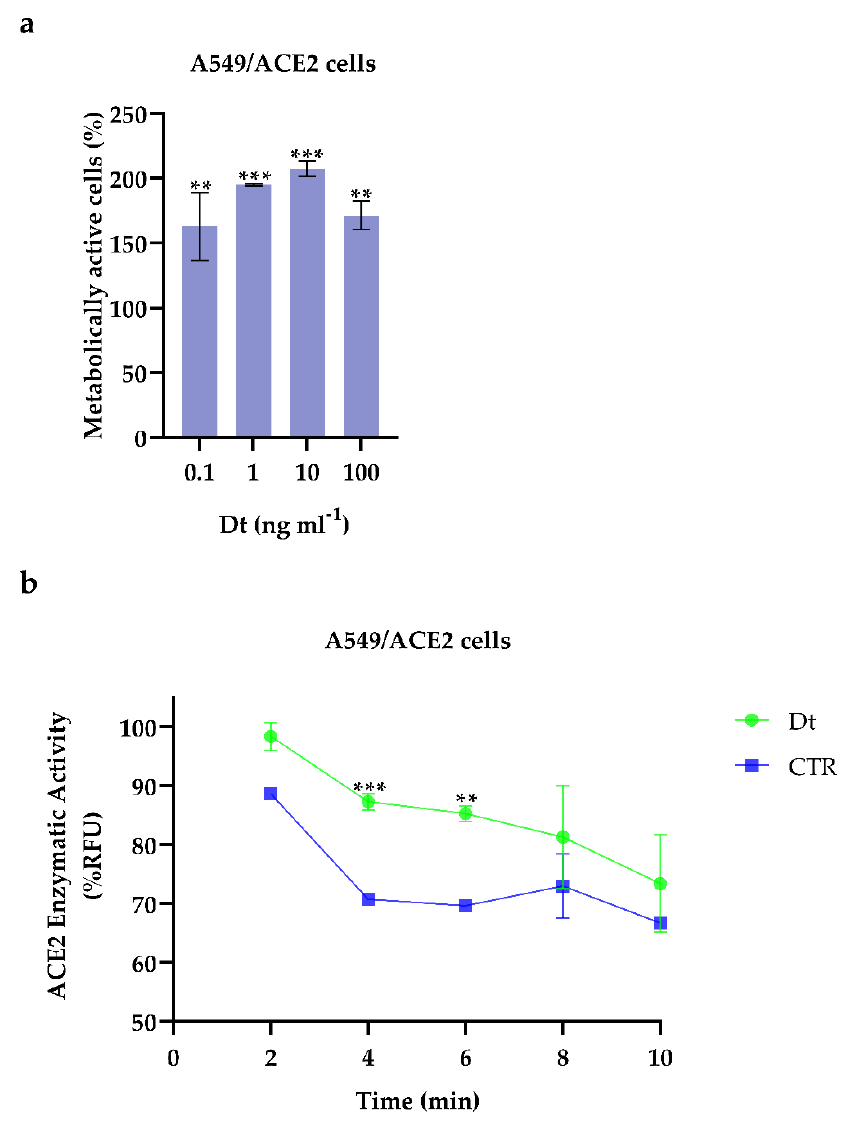
Figure 1. ( a ) Cell viability assays on A549-hACE2 cells treated for 48 h at four Dt concentrations. Values are expressed as mean ± SD of metabolically active cells compared to control (no Dt, 100% of metabolically active cells). All concentrations tested showed significant differences compared to the control (no Dt, p - value ≤ 0.0001; Dunnet’s test) ( b ) ACE2 enzymatic activity screening assay on A549-hACE2 cells treated for 24 h with 0.1 ng mL −1 of Dt. Values are expressed as mean ± SD of %RFU (Relative Fluorescence Units). Asterisks indicate the statistically significant difference compared to the respective control *** p ≤ 0.001, ** p ≤ 0.01; Sidak’s test).